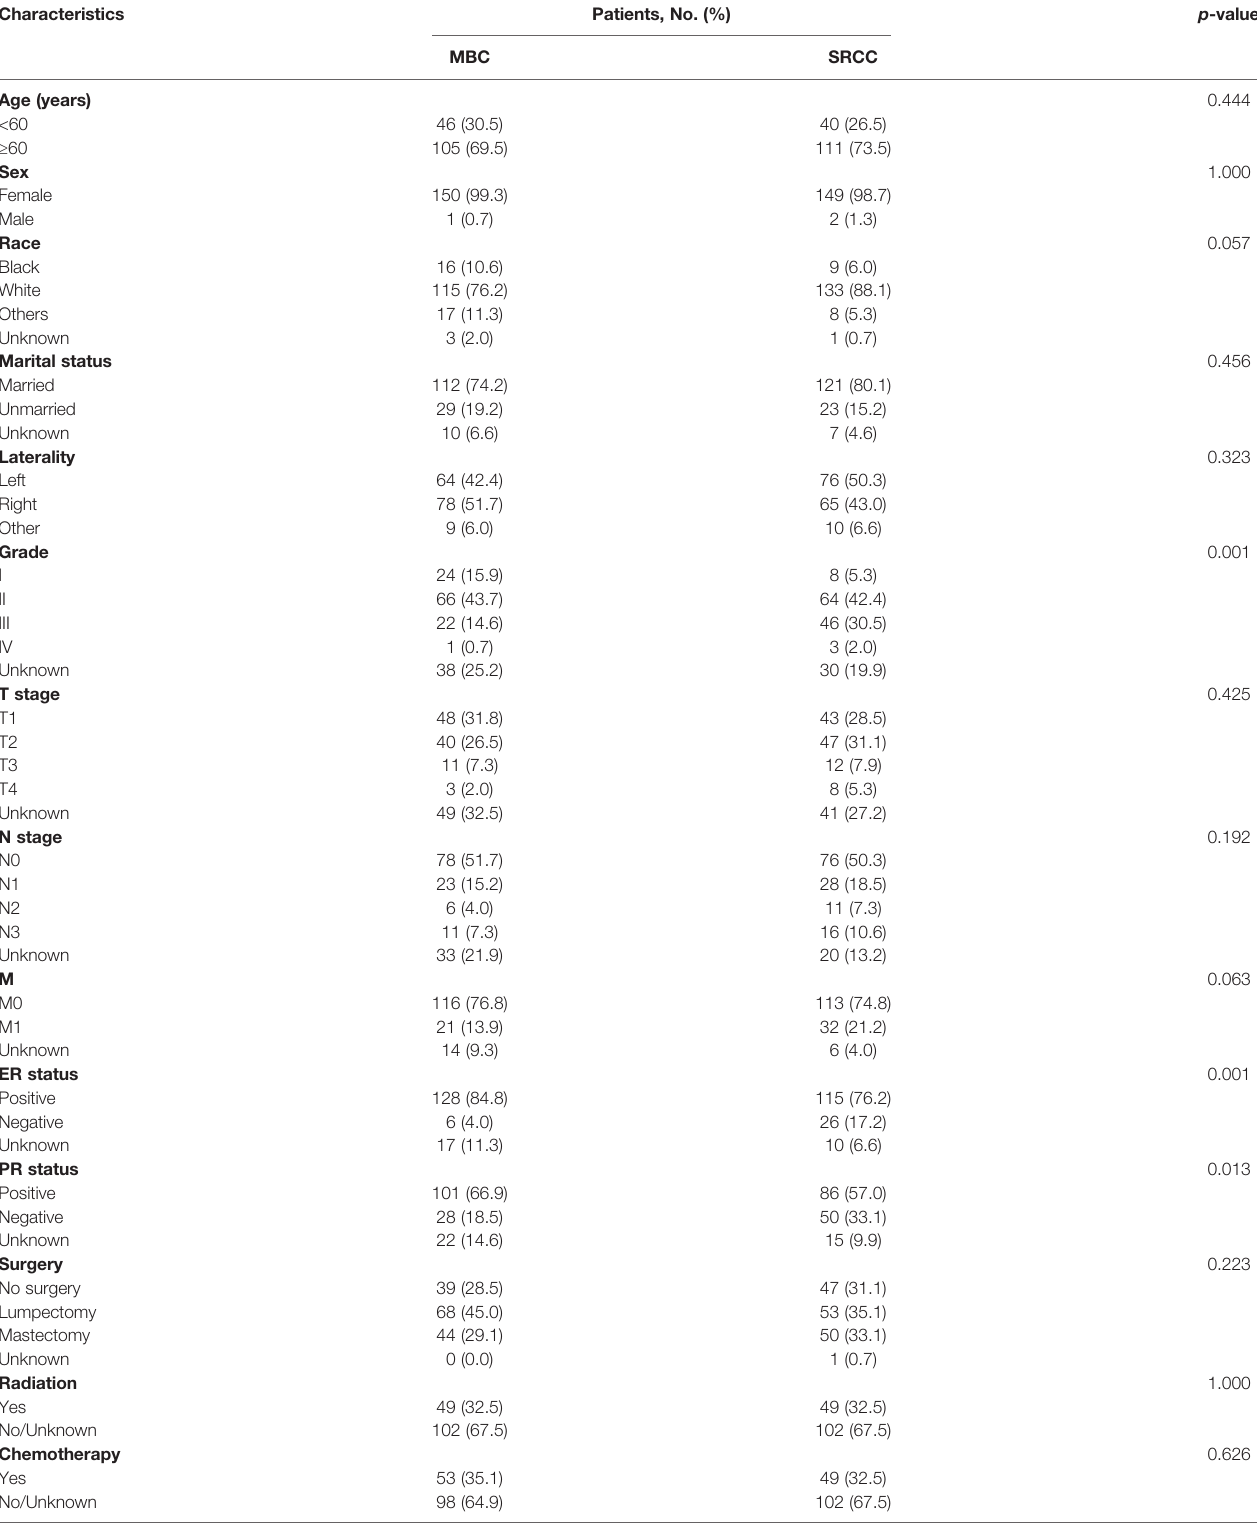
TABLE 2 | Comparison of baseline characteristics of SRCC between MBC after PSM.